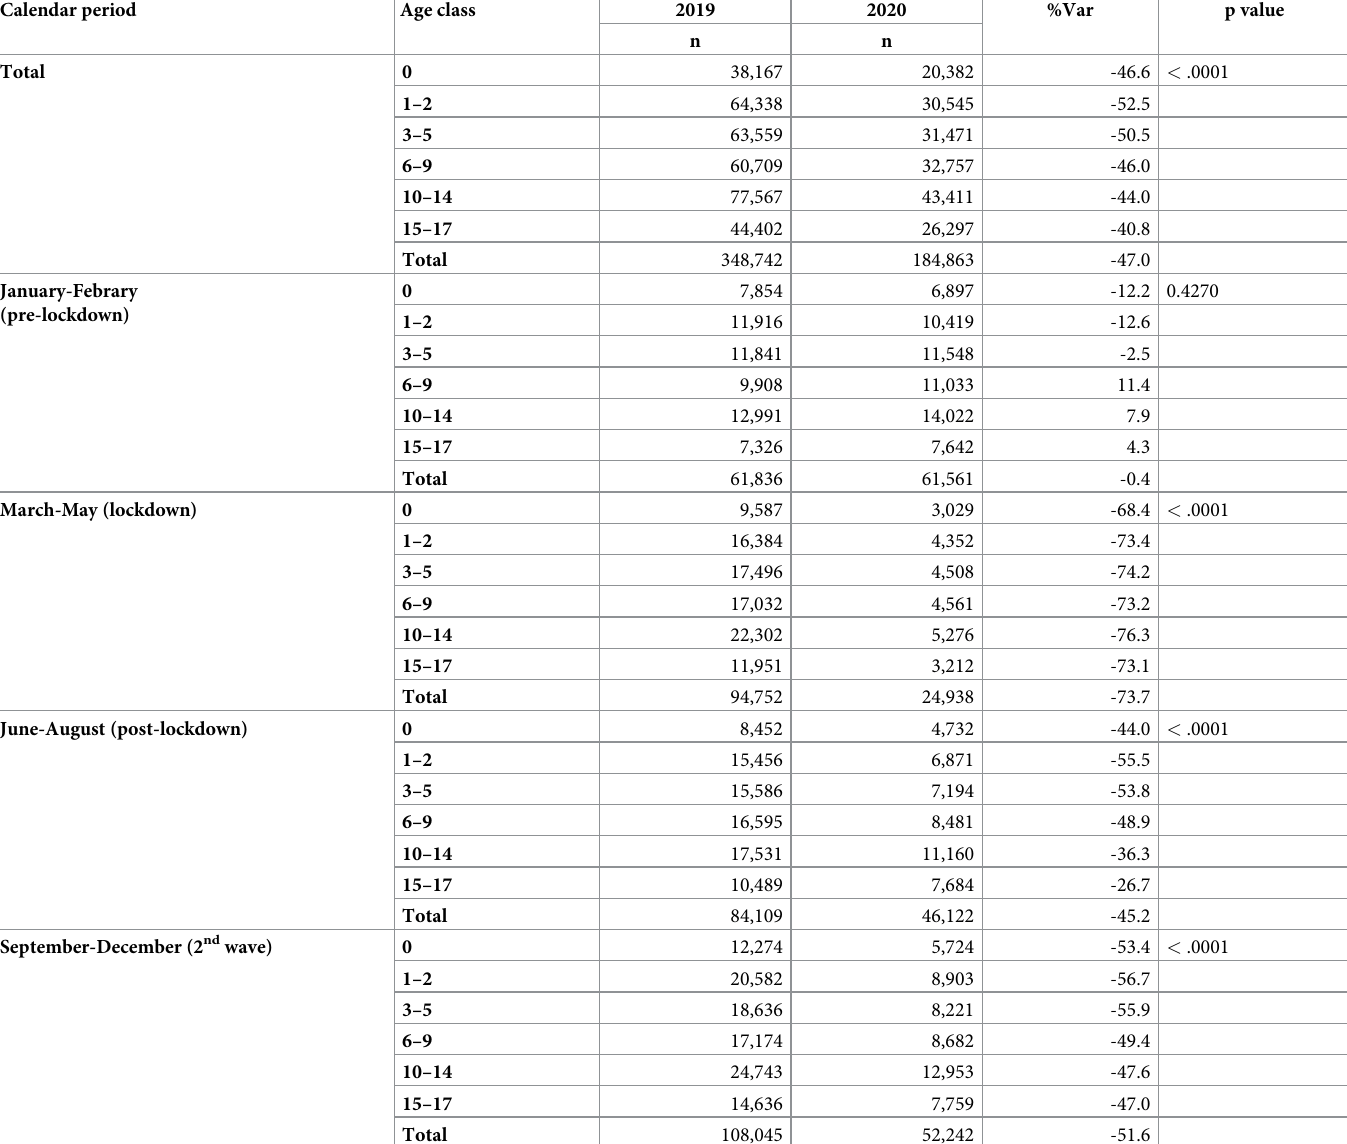
Table 1. Pediatric accesses in EDs of Lazio Region, stratified by age-class and calendar period (2019,